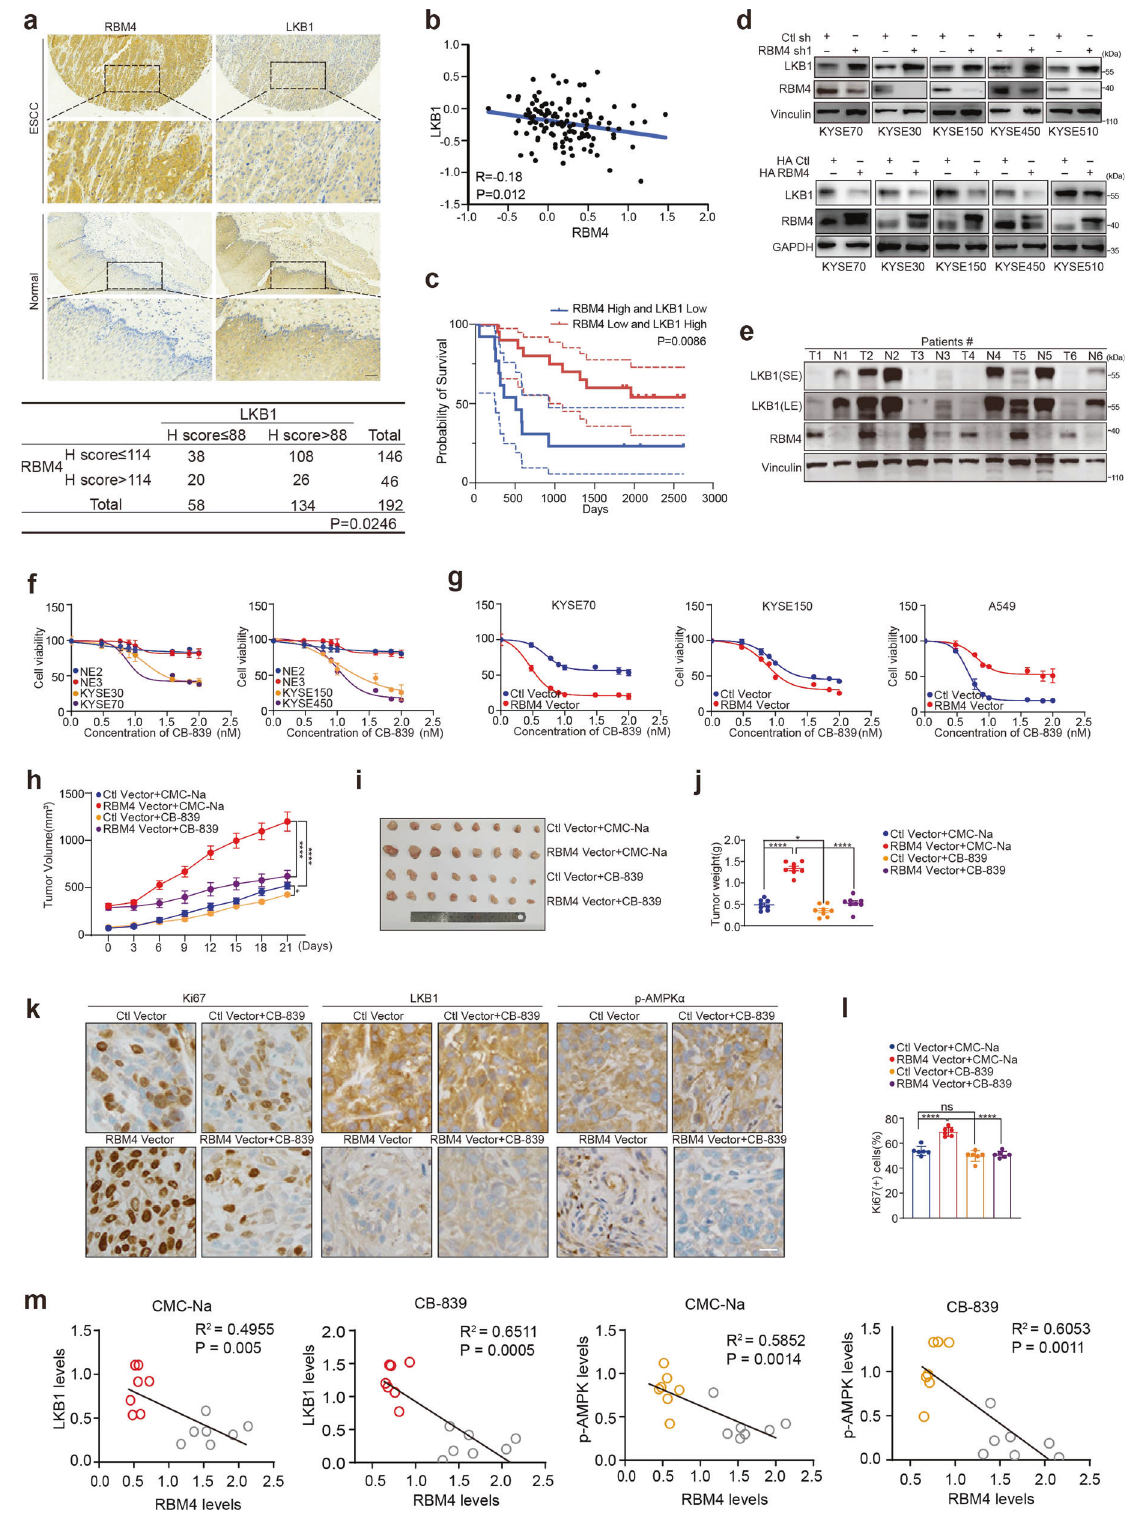
response. 92 – 94 The conversion of glutamine to glutamate is catalyzed by glutaminase (GLS), which is frequently upregulated in some types of cancer cells. 8,95,96 The higher demand and dependency of glutamine make such cancer cells more vulnerable to glutamine deprivation as compared to normal cells. 7,97,98 Based Signal Transduction and Targeted Therapy (2023)